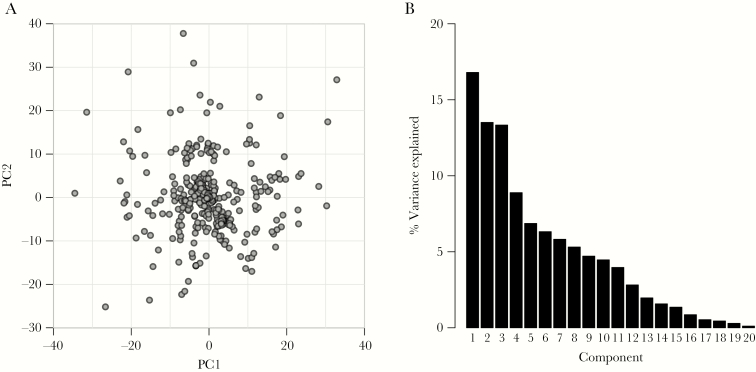
Principal component analysis across the Democratic Republic of the Congo. A, Scatterplot of the first and second principal components from the principal component analysis of the 20 microsatellites. B, Histogram of the percentage of variance accounted for by all 20 components. The first 2 components account for 30% of the total variation and show no clear population structure. Abbreviation: PC, principal component.